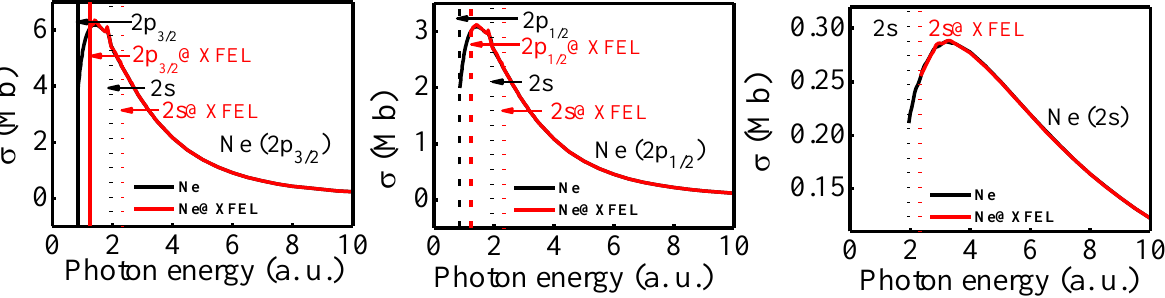
Figure 3. Photoionization cross section (σ) of 2p 3/2 (Left), 2p 1/2 (Middle), and 2s (Right) subshells of Ne (black) and Ne@XFEL (red). Solid, dashed, and dotted vertical lines represent the threshold for 2p 3/2 , 2p 1/2 , and 2s thresholds of free (black) and confined atom (red), respectively.